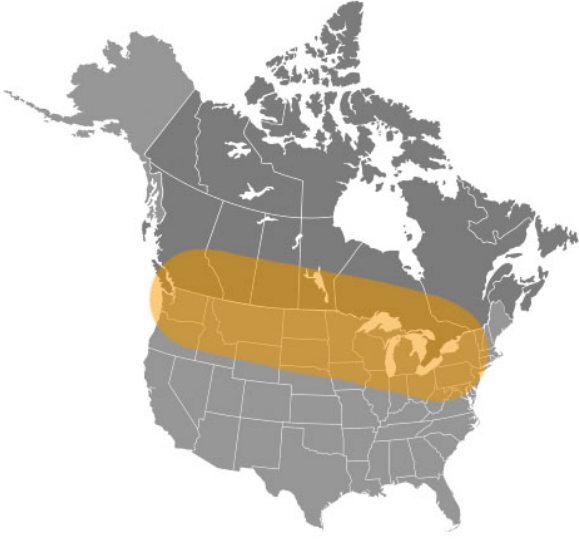
Figure 6. Area studied (Source: